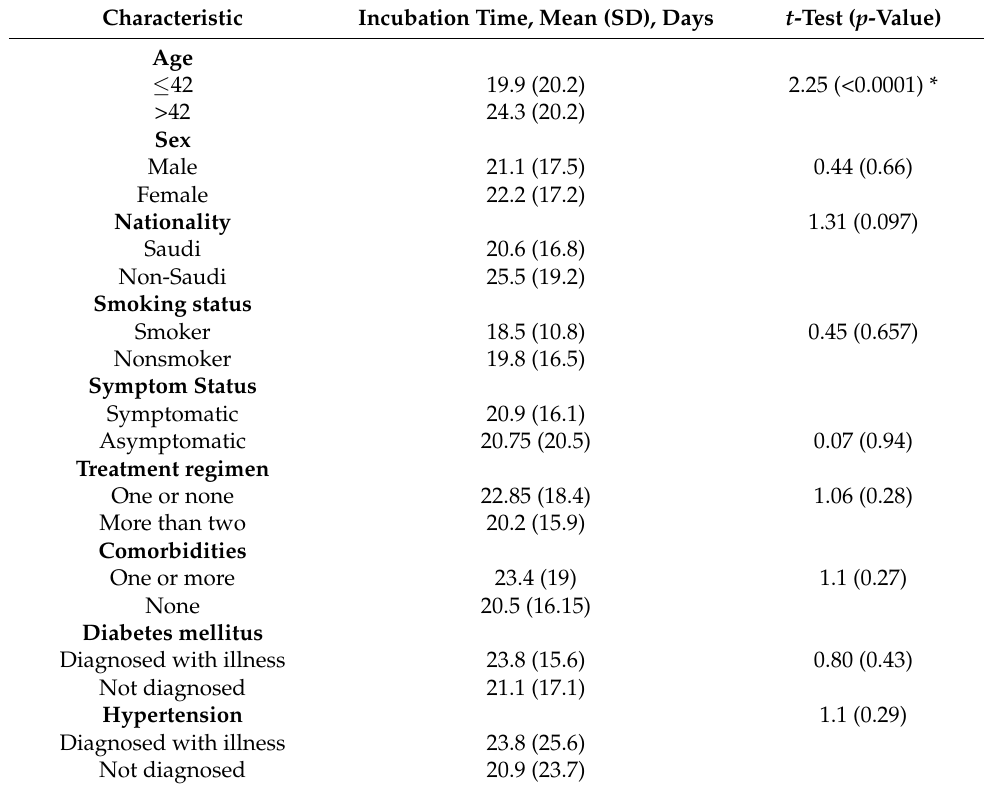
Table 4. Incubation time differences by demographic or clinical characteristic or treatment